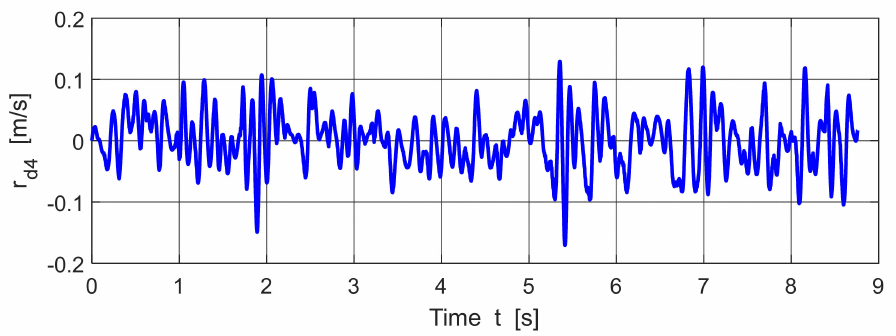
Figure 9. Speed of vertical motion of the right front axle of vehicle.